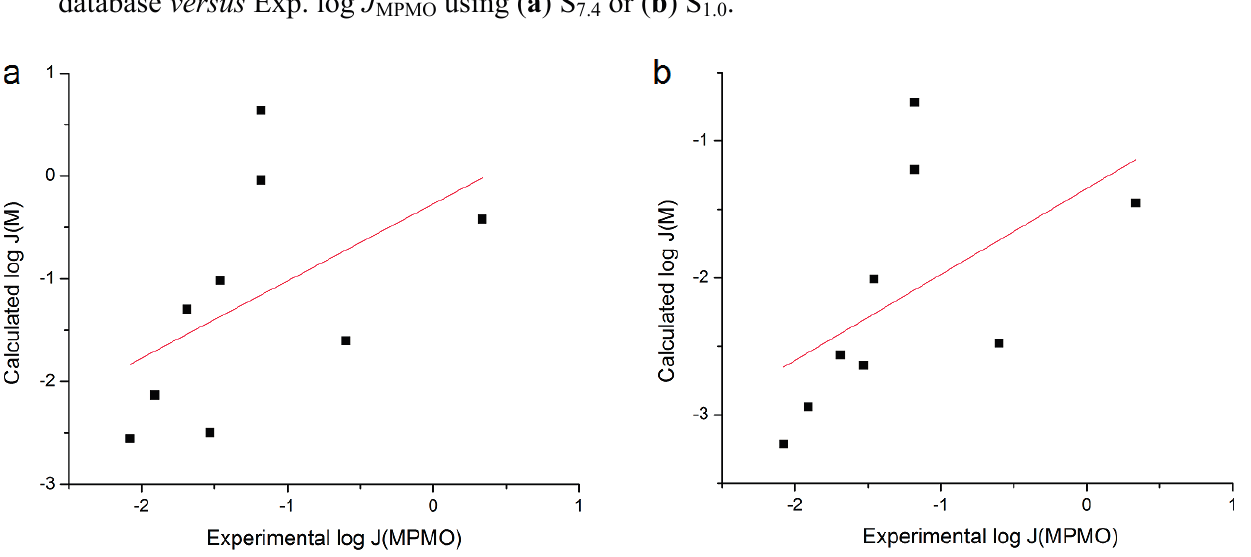
Figure 4. Plot of log J database versus Exp. log J